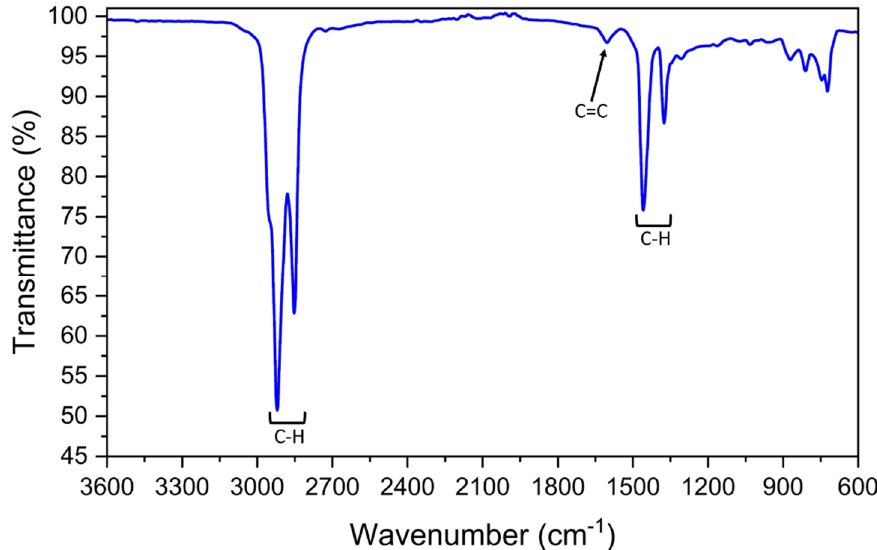
Figure 4. FT-IR spectrum of marine fuel.